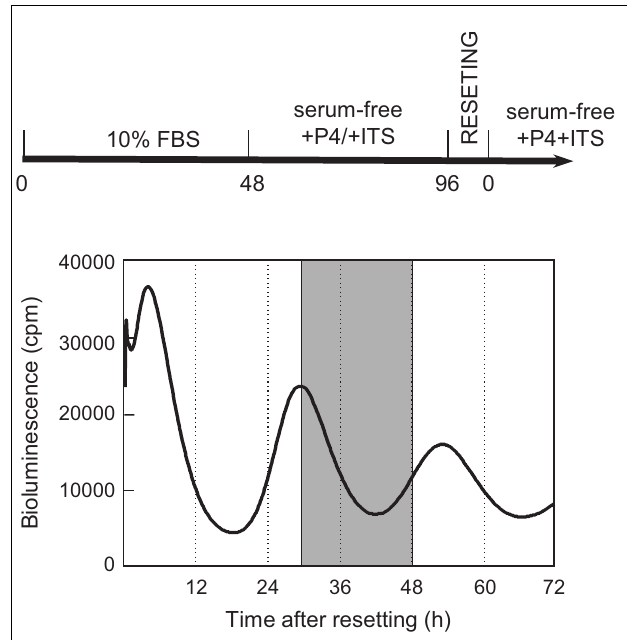
FIGURE 1 | Isolation protocols of total RNA samples from cultured uterus endometrial stromal cells after dexamethasone synchronization . According to the second to the third phases of the Per2-dLuc oscillation, total RNA samples ( n = 3) individually isolated from cultured UESCs at 30, 36, 42, and 48h ( shadow area ) after dexamethasone synchronization were used for microarray analysis.